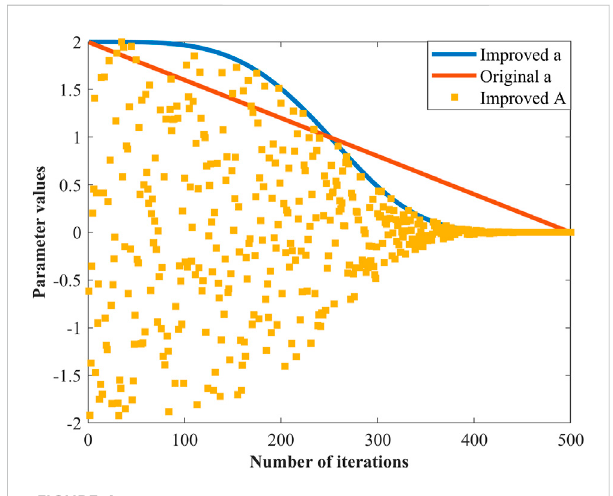
FIGURE 4 Distribution of the non-linear convergence factor a with coef fi cient A.